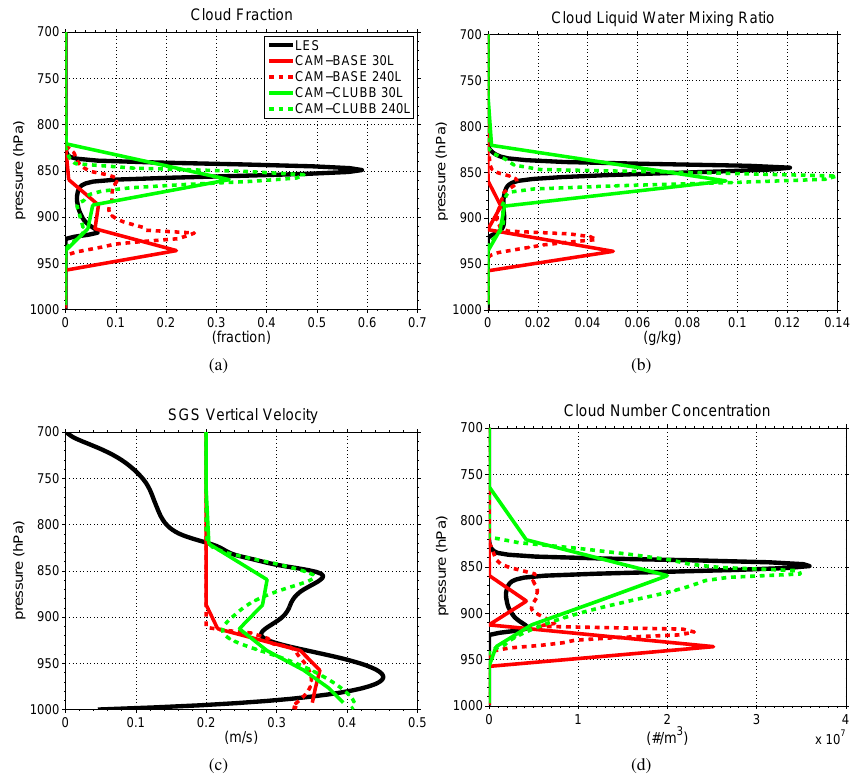
Fig. 7: Same as Fig. 2 except SCAM profiles represent ATEX simulations averaged over hours 4–8, with fixed ∆ t =300s and 30 and 240 vertical levels.